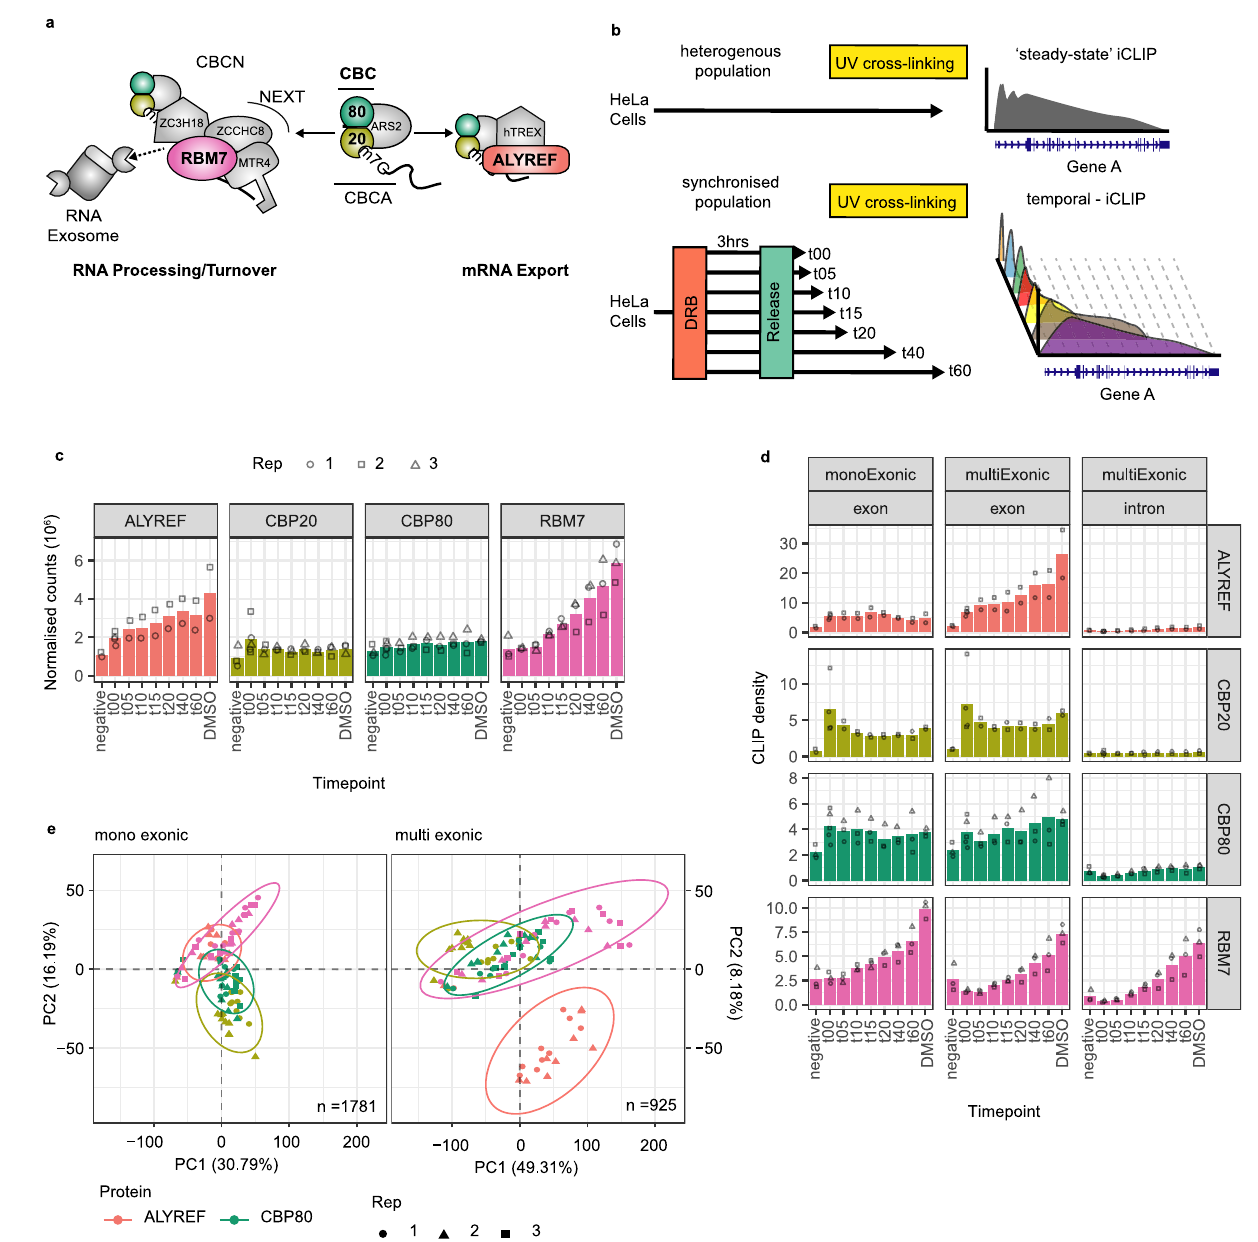
Fig. 1 | Temporal-iCLIP uncovers dynamic RBP-RNA-binding pro fi les. a Simpli fi ed overview of the CBC and its two cofactors, ALYREF and RBM7, with relevance for the present study. See text for further detail. b Schematic outline of thetiCLIPapproach(lowerpanel)ascomparedtoregularsteadystateiCLIP(upper panel). c Histograms showing the average number of normalised mapped tiCLIP reads. Numbers from individual biological replicates are shown as circles, squares and triangles. ‘ Negative ’ timepoints represent controls in which blank magnetic beads were used (negative anti-GFP lanes) on unsynchronised samples.